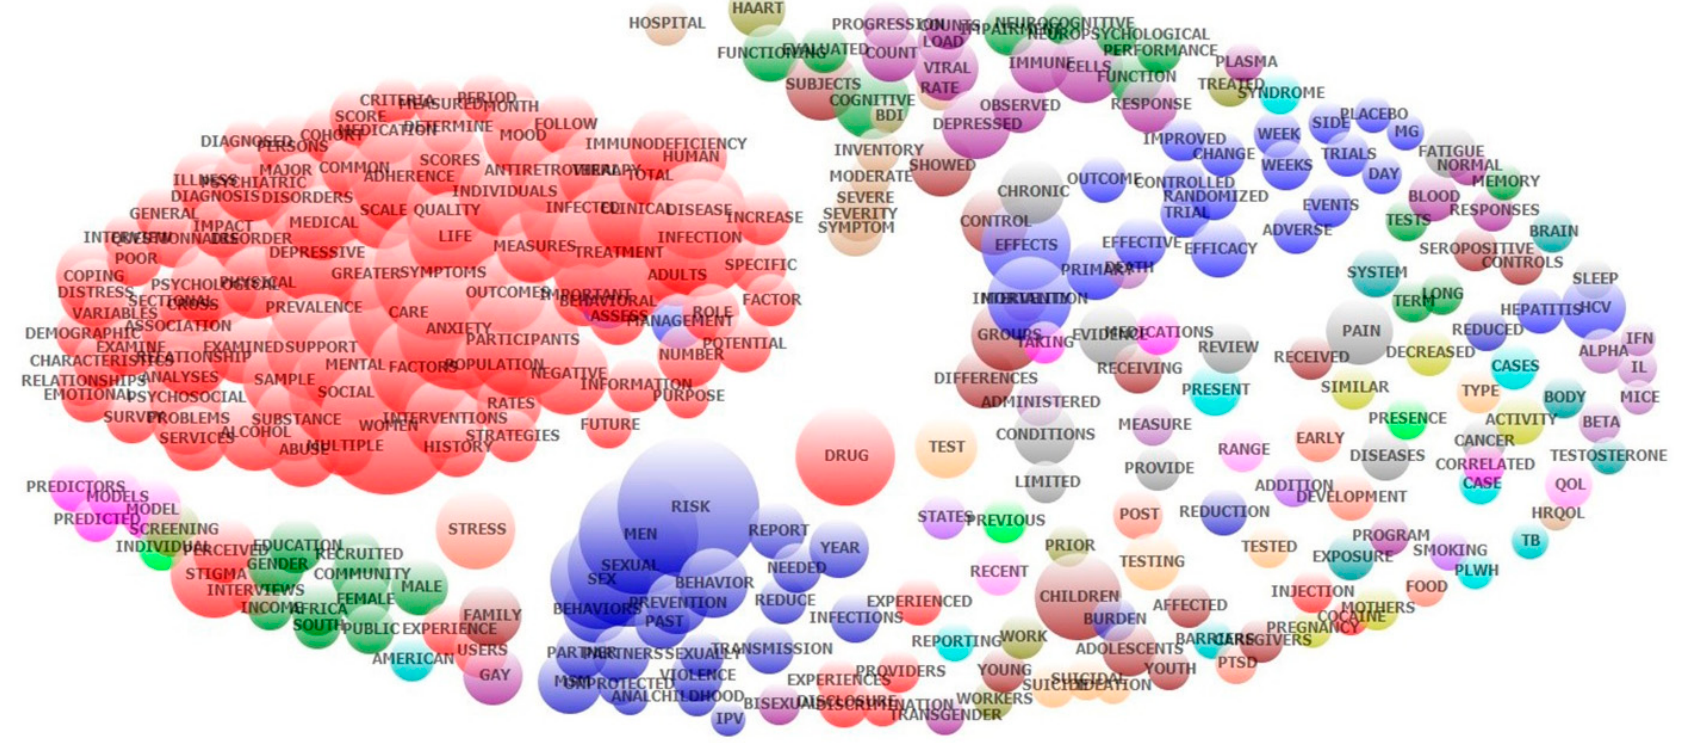
Figure A1. Co-occurrence of most frequent topics emerging from exploratory factor analysis of abstracts’ contents.